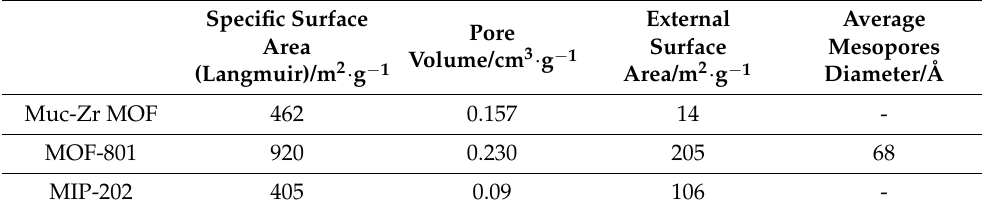
Table 1. Textural parameters after nitrogen adsorption at 77